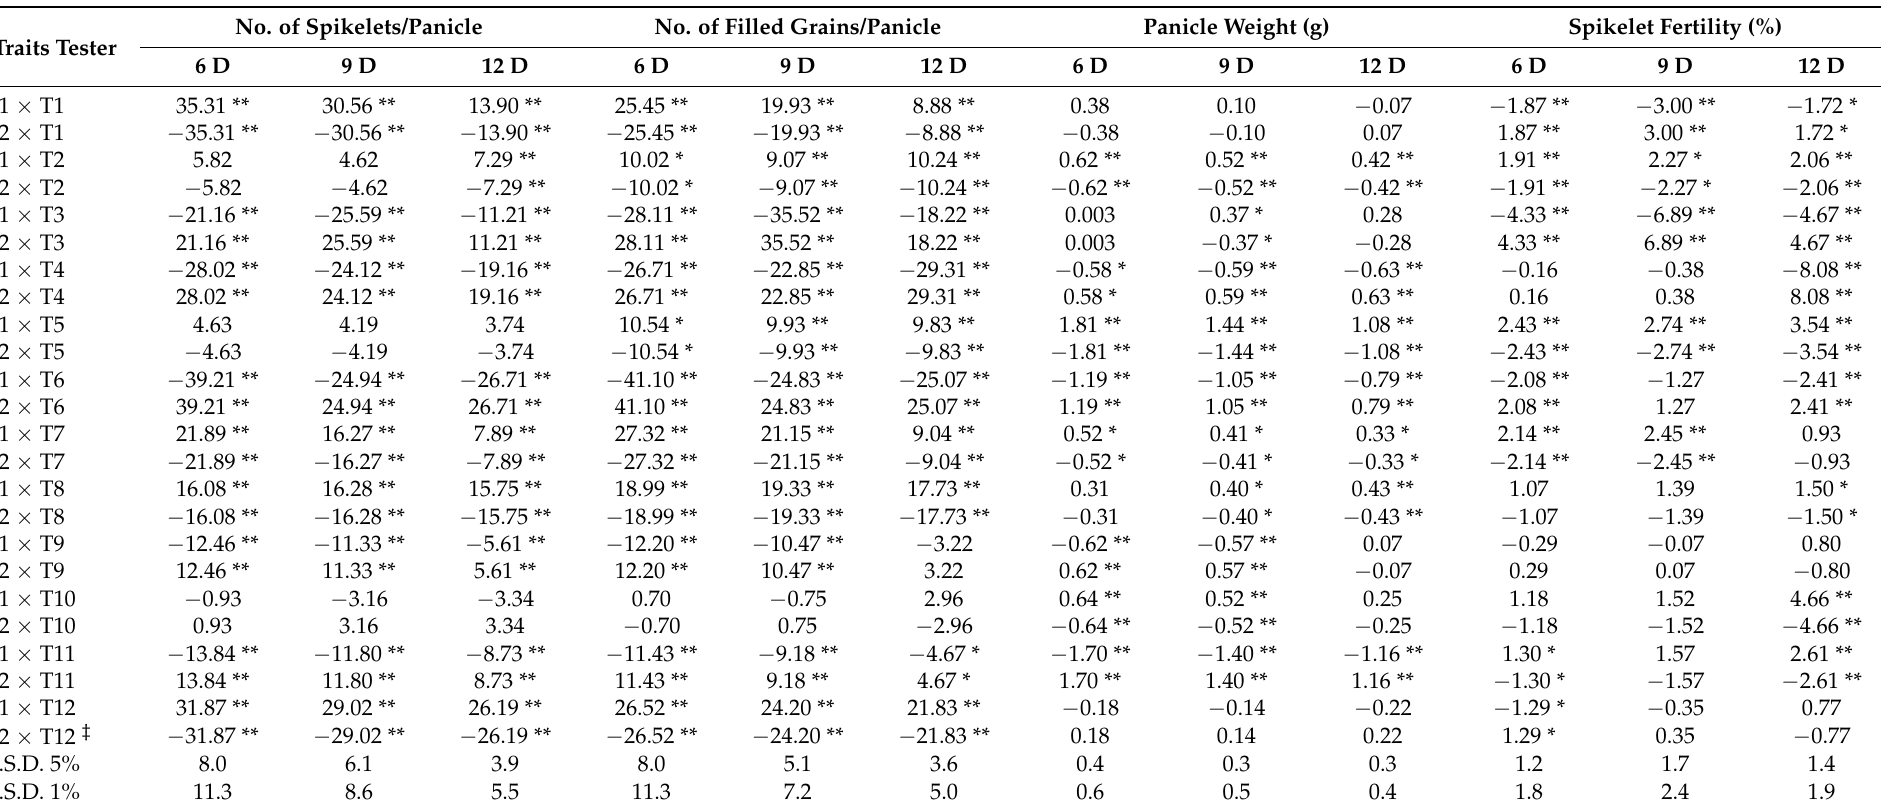
Table 9. Specific combining ability effects of the crosses for no. of spikelets/panicle, no. of filled grains/panicle, panicle weight and spikelet fertility percentage traits. Traits